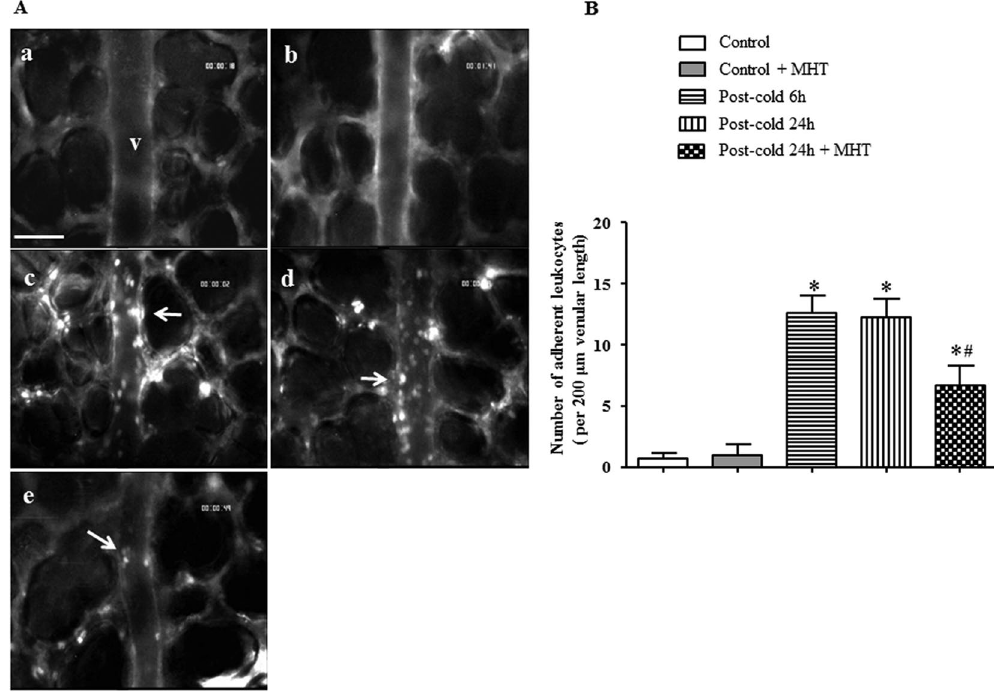
Figure 1. Effect of MHT post-treatment on leukocyte adhesion to pulmonary venules after cold-warm-cycles. ( A ) Representative images of rat pulmonary venules in Control (a), Control + MHT (b), Post-cold 6 h (c), Post-cold 24 h (d), and Post-cold 24 h + MHT (e) group, respectively. Arrows indicate adherent leukocytes. Bar = 50 μ m. ( B ) Statistical result of the number of leukocytes adherent to the pulmonary venules of rats in different groups. N = 6. Results are presented as mean ± SE. * P < 0.05 vs. Control group; # P < 0.05 vs. Post-cold 24 h